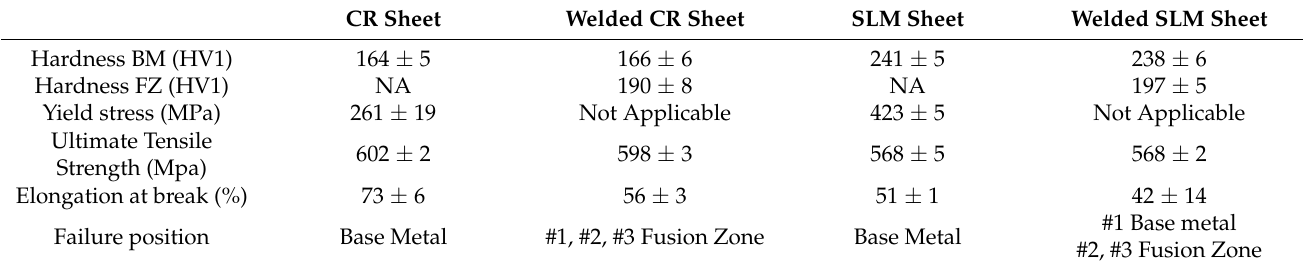
Table 9. Vickers hardness of Base Metal (BM) and Fusion Zone (FZ) and tensile properties of the reference and welded